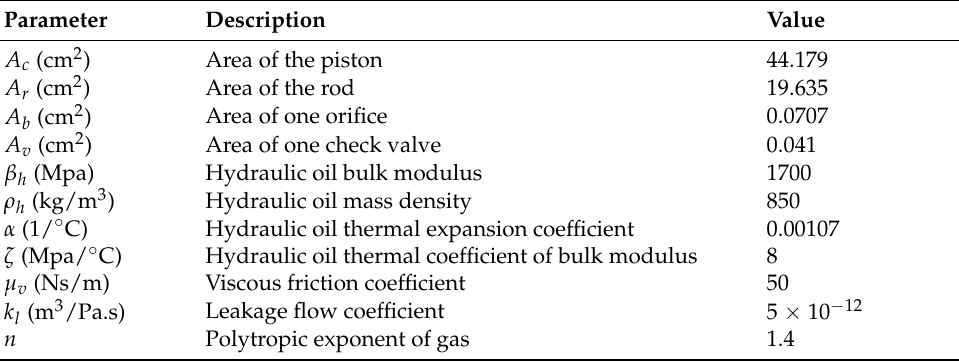
Table 1. Constant parameters of the hydro-pneumatic suspension (HPS)